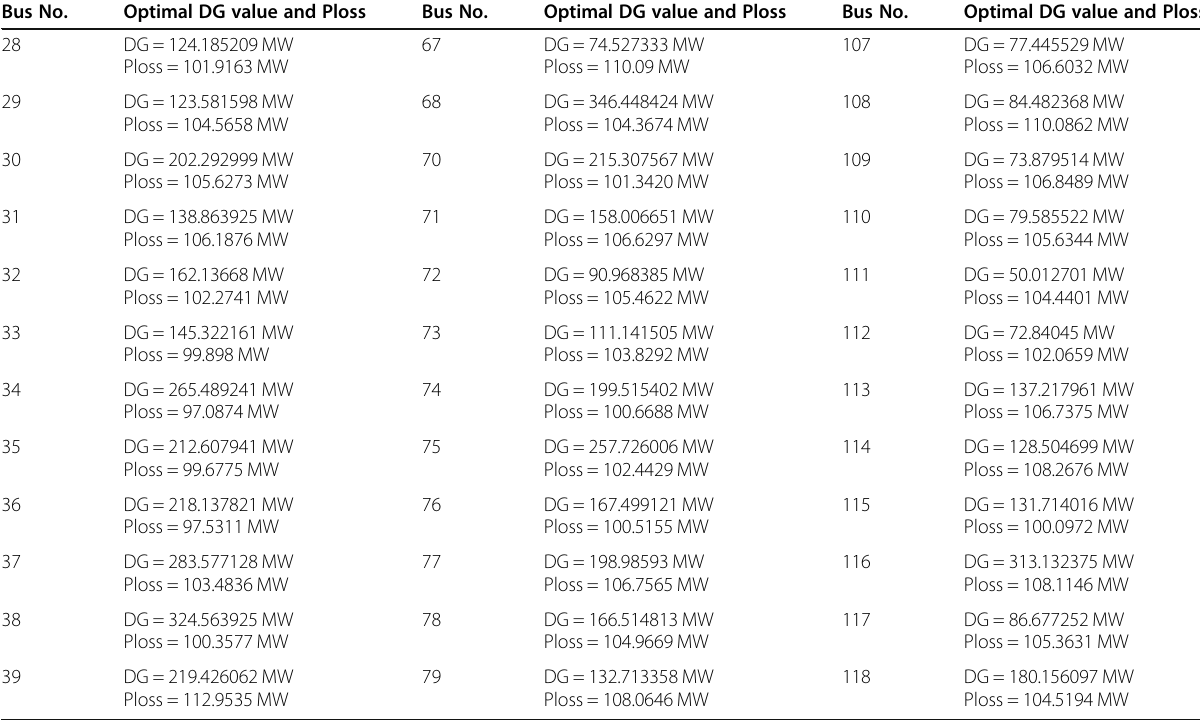
Table 22 Optimum solution for the IEEE 118 bus system with DG individually injected at each bus using JAYA algorithm (Continued) Bus No.